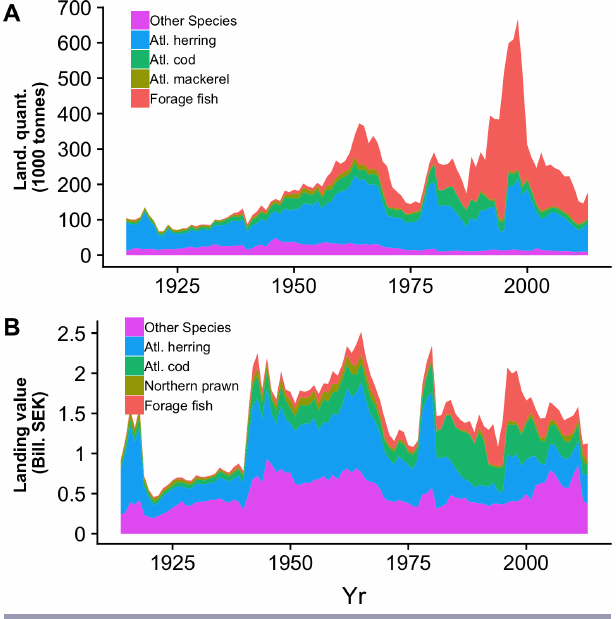
Fig. 5 . Landings in the Swedish sea fishery 1914–2015. (A) Landing quantities. Note that the trend is mainly driven by two groups, herring ( Clupea harengus ) and forage fish, which in turn consists of a few different species used for reduction to fish meal and fish oil, mainly sprat ( Sprattus sprattus ), blue whiting ( Micromesistius poutassou ), sand eel ( Ammodytes sp.), and herring. (B) Landing value. Note the more even distribution between groups, and the relatively large share of